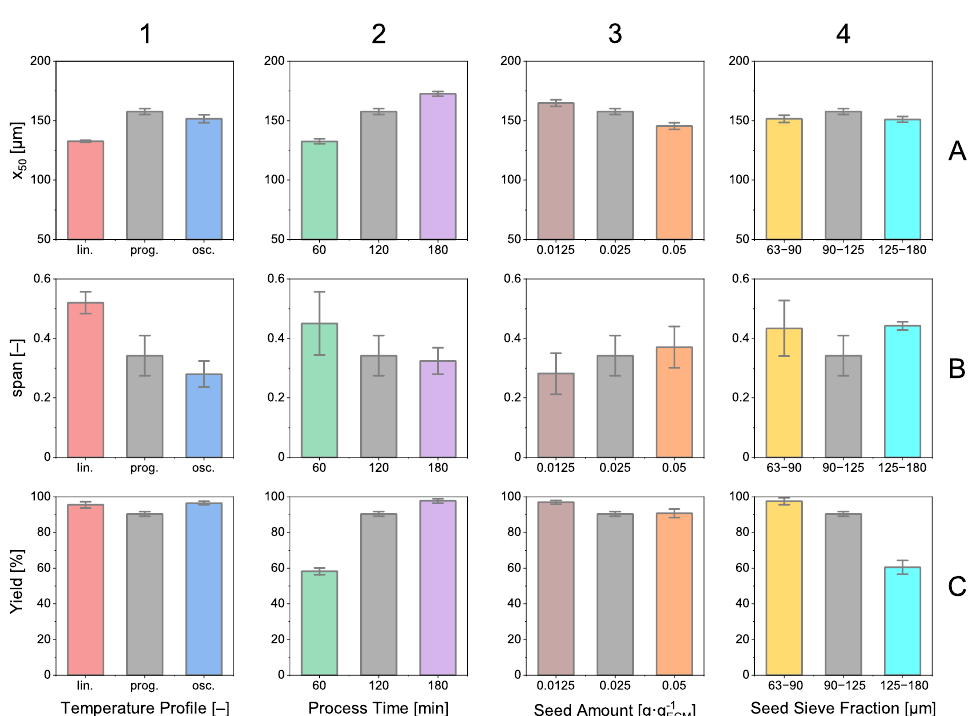
Figure 12. Relevant product crystal properties (median, span , yield) for the experiments discussed before. Error bars are calculated from triple experiments. The color coding for the diagram is consistent throughout the contribution. One color represents one set (triple) of